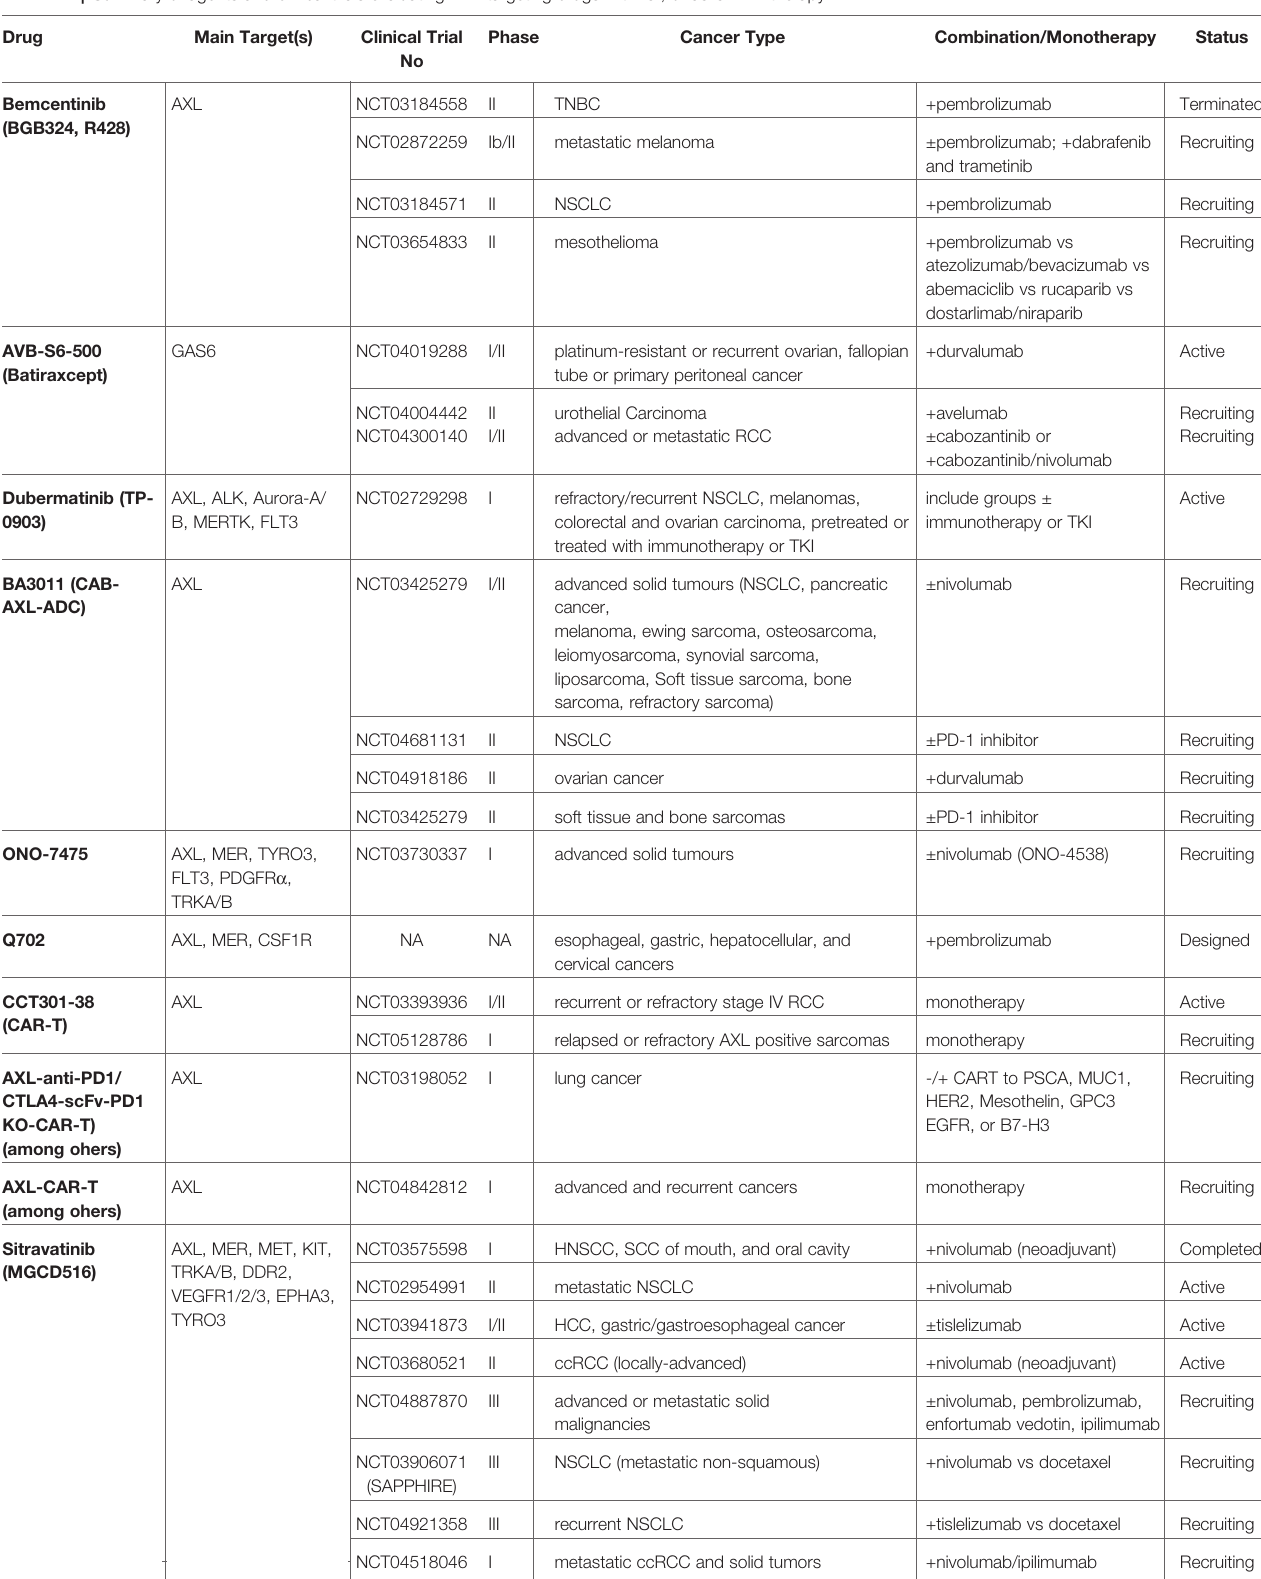
TABLE 1 | Summary of agents and clinical trials evaluating AXL-targeting drugs with ICI, or as CAR-T